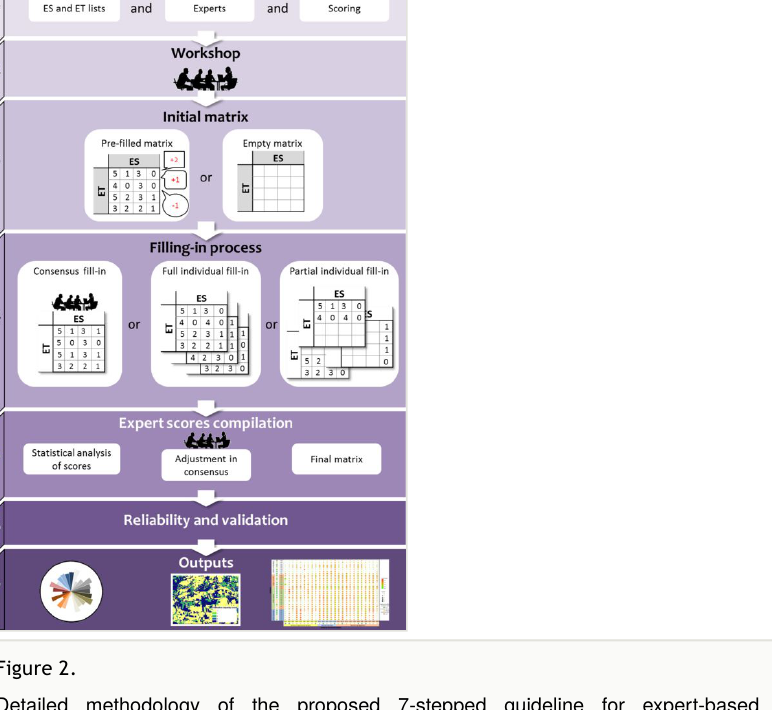
Detailed methodology of the proposed 7-stepped guideline for expert-based matrix